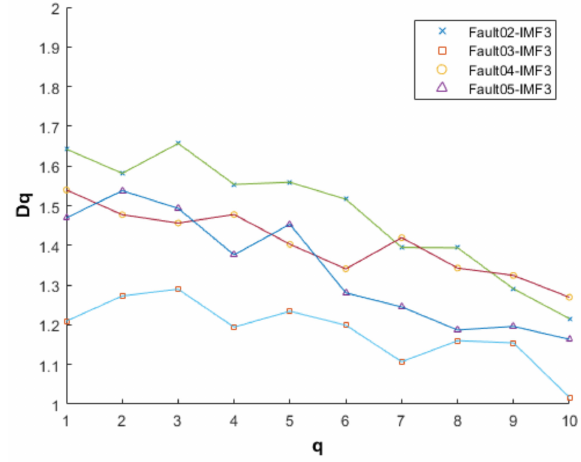
Figure 19. IMF3‑EMD box fractal dimension map.